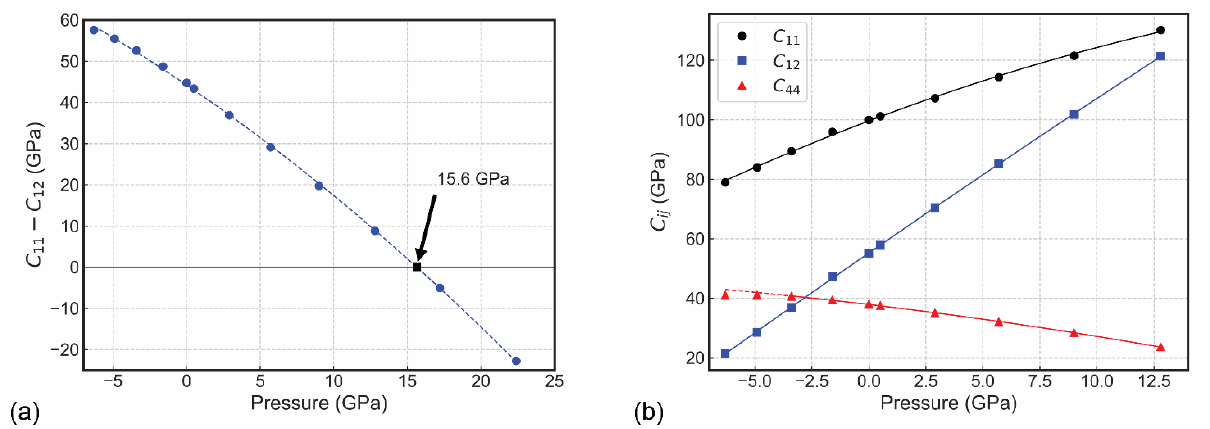
Figure 4. ( a ) Evolution of the mechanical stability criterion C 11 − C 12 > 0, with the black square showing the occurrence of instability above 15.6 GPa. ( b ) Elastic moduli of sodalite as a function of pressure, within the stability region. The lines are 2nd ‐ order polynomial fit of the data (see text for details).